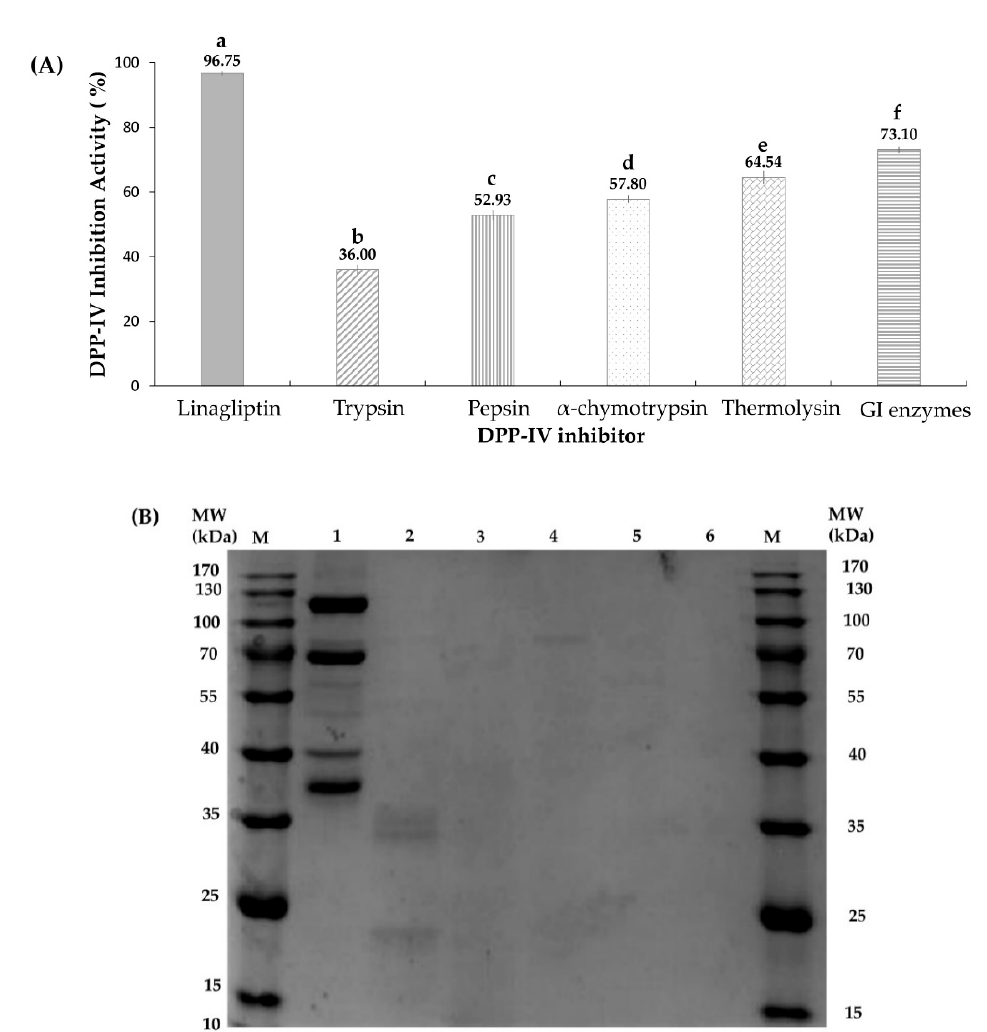
Figure 1. ( A ) DPP-IV inhibitory activity with soft shelled turtle yolk (SSTY) hydrolysates by